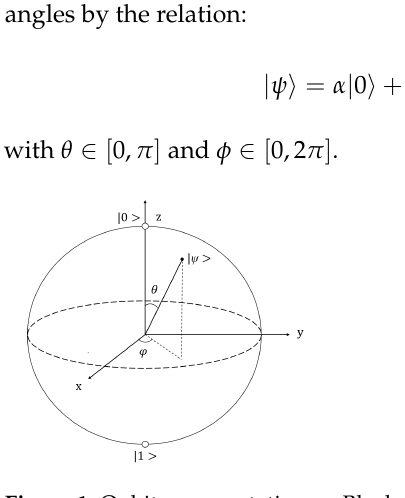
Figure 1. Qubit representation on Bloch